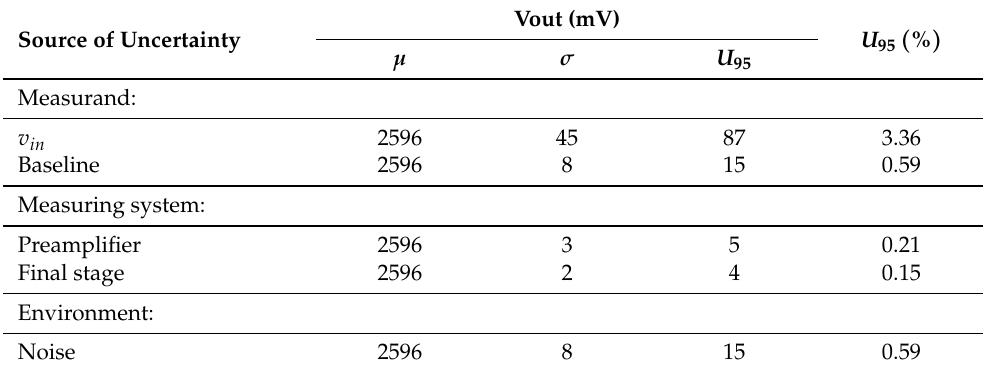
Table 4. Individual or block simulation of uncertainty sources after design